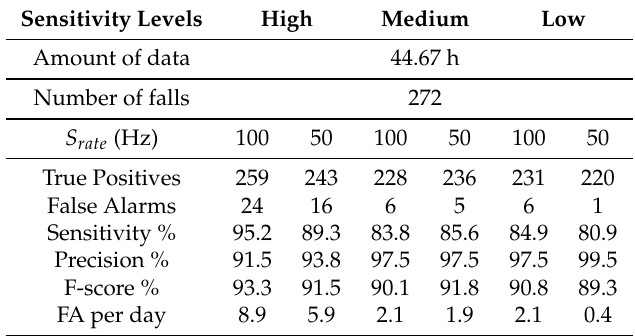
Table 4. Results of the test using the DS-2 with both 50 and 100 Hz sets of thresholds. Sensitivity Levels